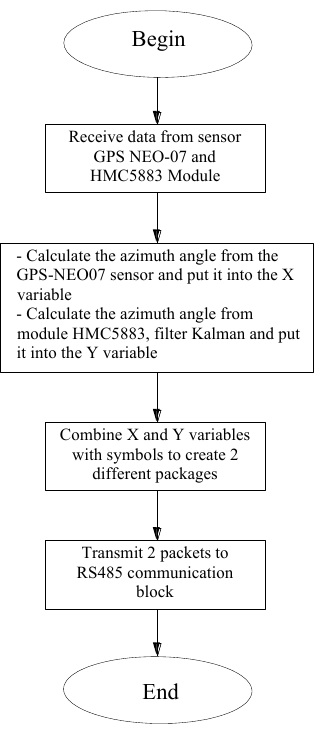
Fig. 8. Algorithm for the DMC.